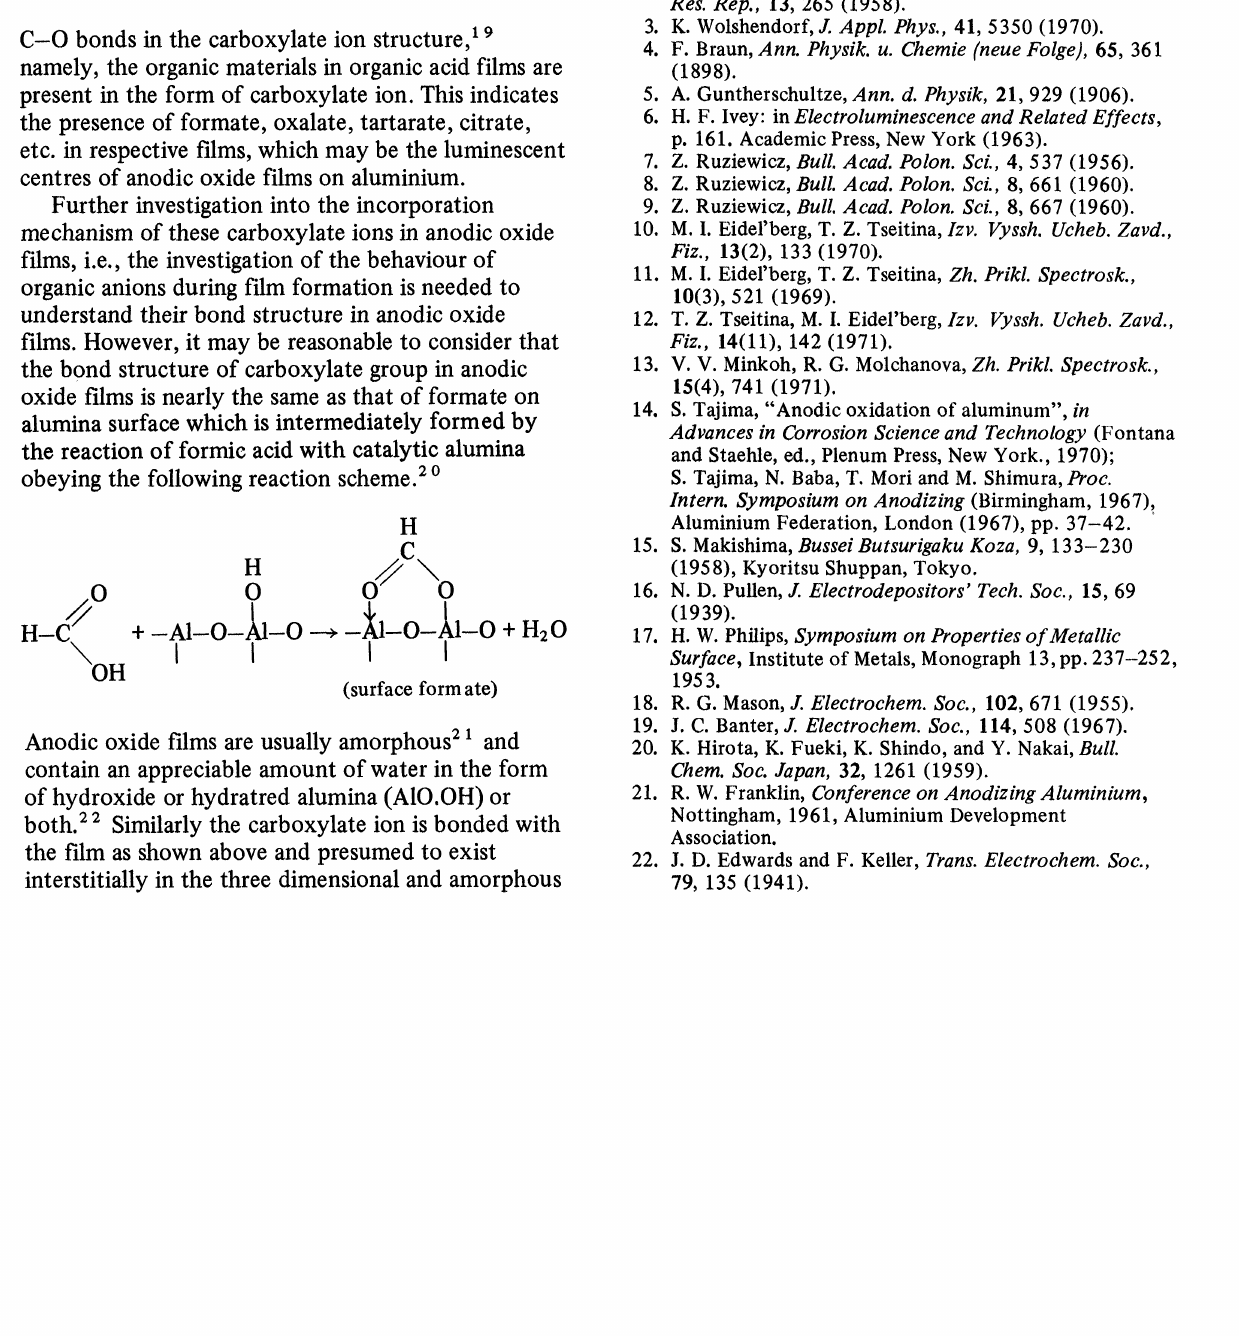
Infrared transmittance spectra of sulphuric acid (dotted line) and oxalic acid